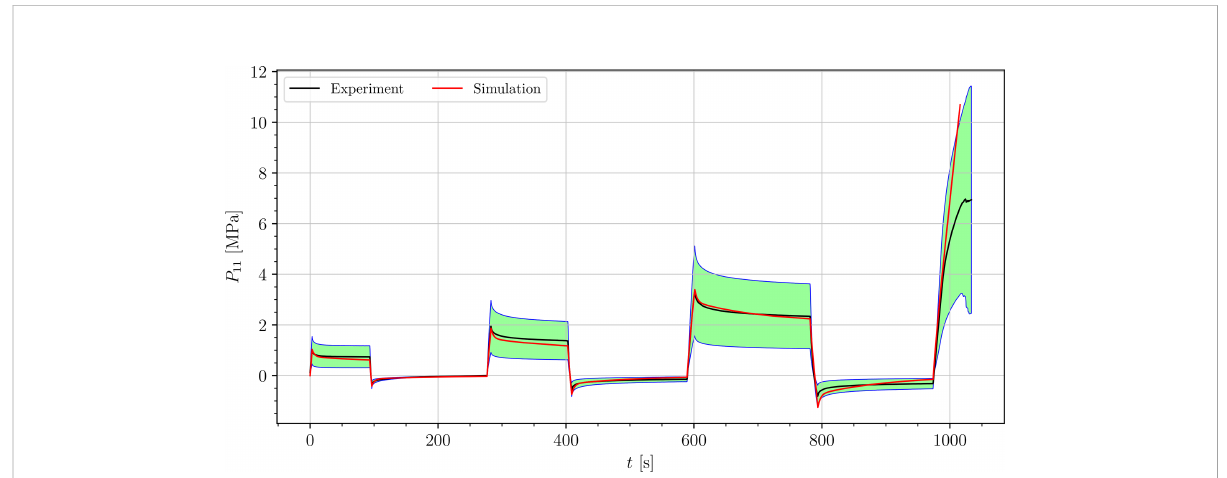
FIGURE 9 Simulation of the cyclic uniaxial tensile stress-relaxation test of the petiole (red curve). Green region indicates a standard deviation from the averaged experimental result (black